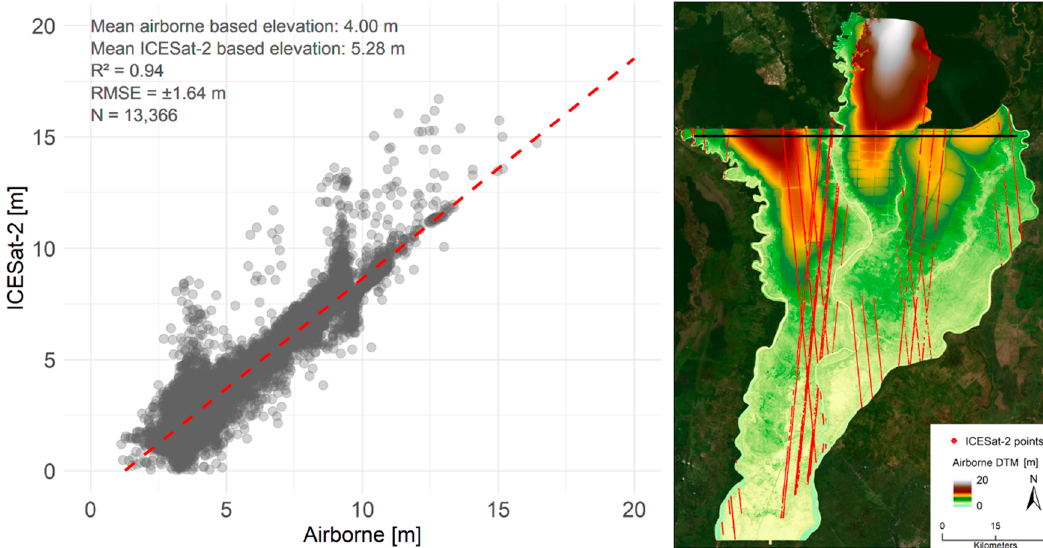
Figure 3. Scatterplot demonstrating the correlation between airborne and ICESat-2 derived DTM measurements. Right panel: the map displays an airborne LiDAR DTM of a large peat hydrological unit (PHU) peatland complex (Sungai Kahayan Sebangau and Sungai Kahayan Kapuas in Central Kalimantan, north–south extent > 100 km). Raised peat domes are visible in dark green to dark brown to white colors. Superimposed are the ICEatS-2 footprints shown as red dots. The black line indicates the location of the transect shown in Figure 4.